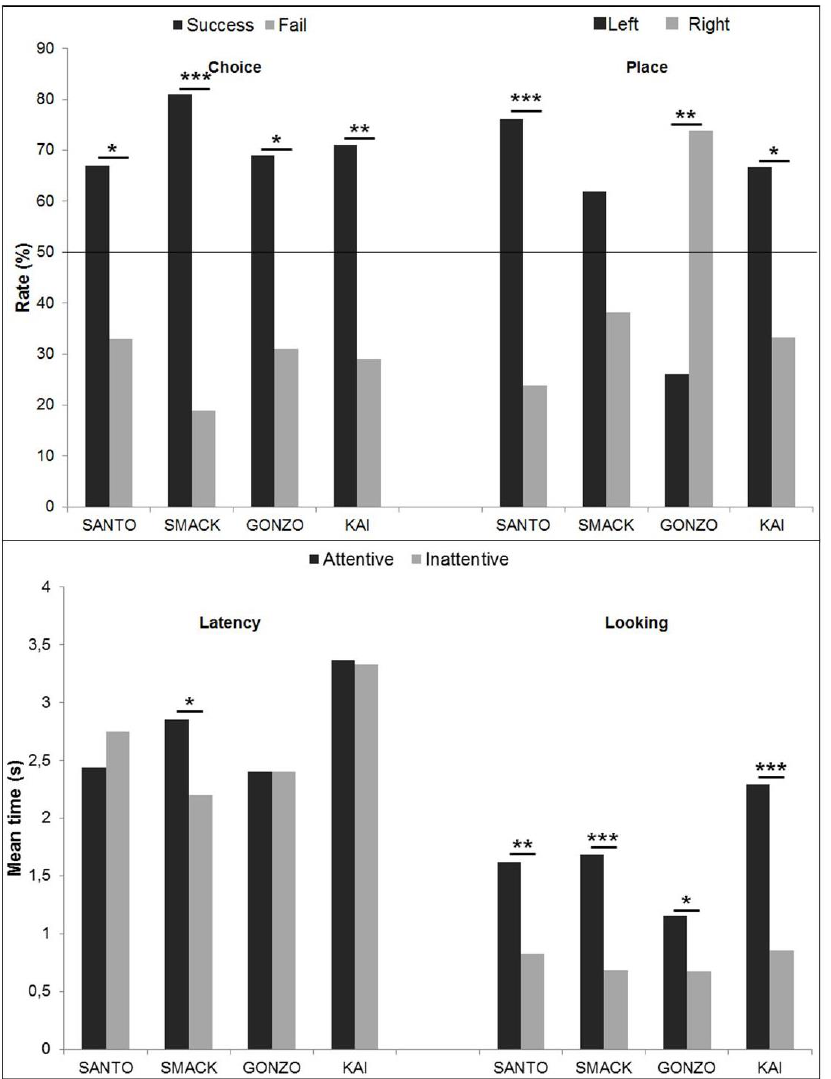
Figure 2. Test 1: body orientation. For each sea lion, Success / Failure rate and place (top) and mean time (s) of the response time (latency) and duration (s) of looking at the caretakers (down) during experiment 1. The line shows the random level with 50%. * = p<0.05; ** = p<0.01; *** = p<0.001 Results. The 4 sea lions failed this test ( N = 168, k = 102, p < 0.01), and they did not preferentially look at the attentive caretaker vs. the inattentive one before choosing (Santo: W = 753.5, p = 0.23; Smack: W = 672.5, p = 0.21; Gonzo: W = 834.5, p = 0.96) (Figure 3). Kaï not only significantly chose the inattentive caretaker ( N = 42, k = 31, p < 0.01), he also looked at her for significantly longer before choosing (Figure 3) (W = 429, p < 0.01). Santo ( N = 42, k = 37, p < 0.001), Smack ( N = 42, k = 37, p < 0.001), and Gonzo ( N = 42, k = 35, p < 0.001) showed a side preference (Figure 3) (right, left, and right,